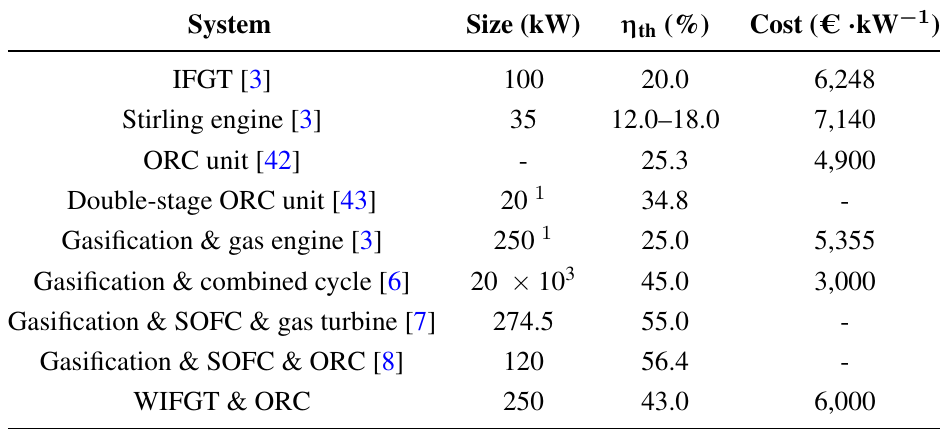
Table 3. Size, overall thermal efficiency and specific cost of possible technologies for the conversion of woodchips into electric power. IFGT: indirectly fired gas